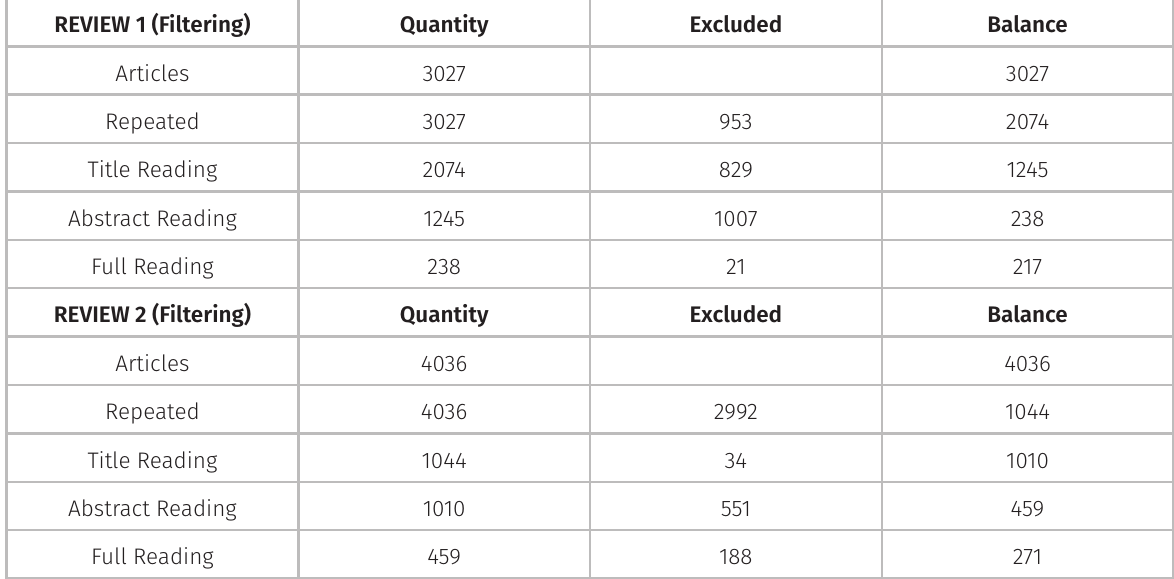
Table II. Filtering results of reviews 1 and